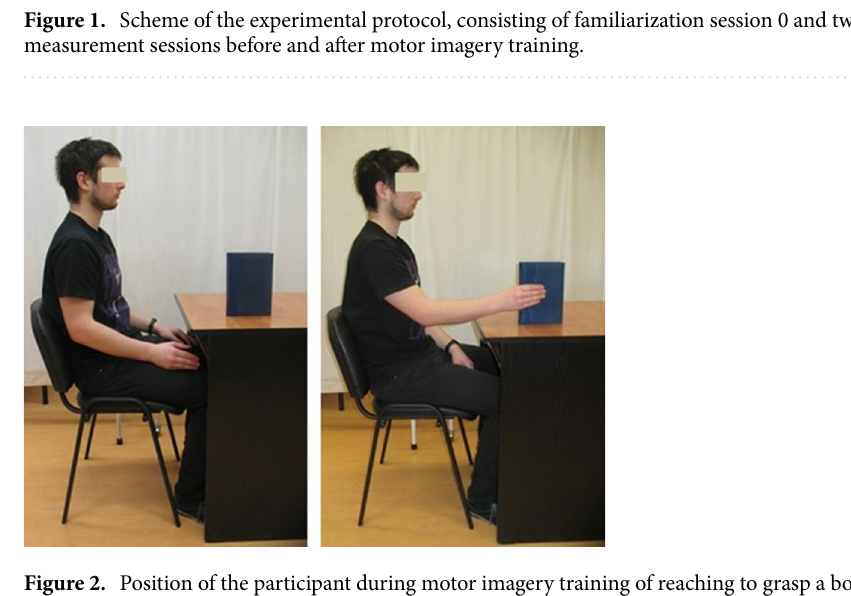
Figure 2. Position of the participant during motor imagery training of reaching to grasp a book task. The participant performed this movement physically three times with the right and left upper limbs